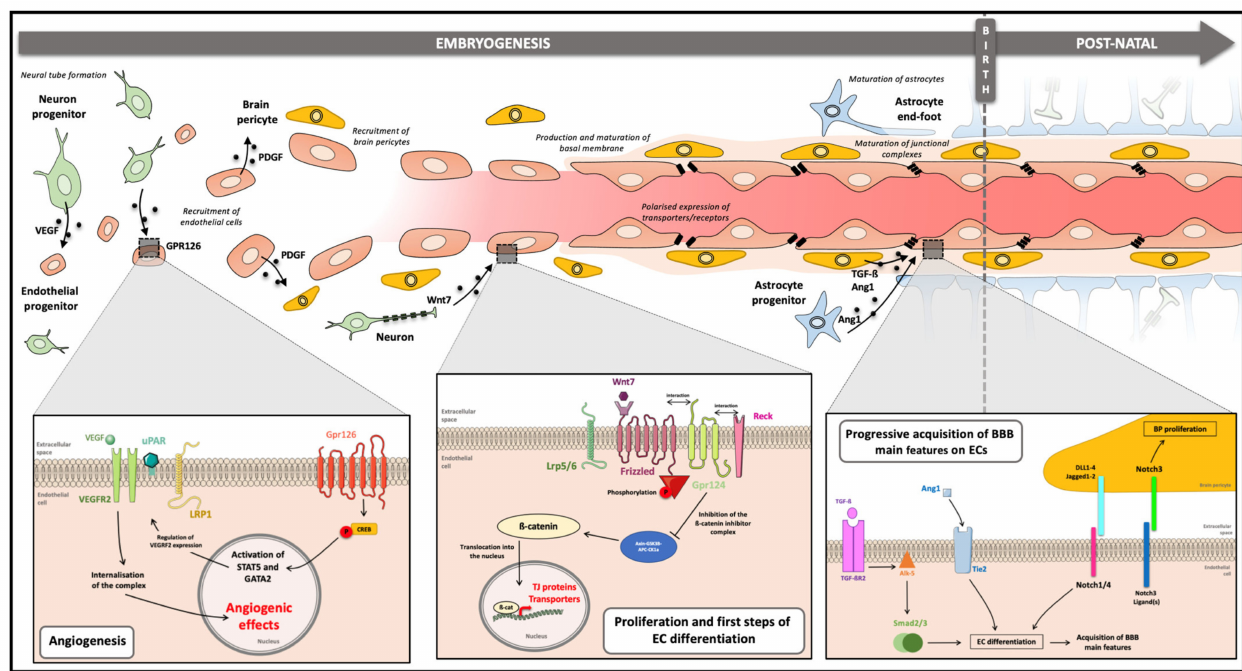
Figure 3. Cell-cell communications during barriergenesis . During embryogenesis, establishment of the BBB phenotype is possible through cell–cell communication processes between components of the NVU. Endothelial progenitors colonise the neural tube in response to the VEGF gradient secreted by neural progenitors, which promotes angiogenesis. The interaction of future BBB ECs with neurons activates several signalling pathways of which the most studied is the Wnt pathway. Thus, the ECs continue to proliferate, and the first steps of differentiation begin. Once established, future ECs meet BPs by secretion of PDGF; this cell–cell interaction is crucial for the differentiation of cells into mature BBB ECs and involves Notch and Smad-dependent signalling pathways.